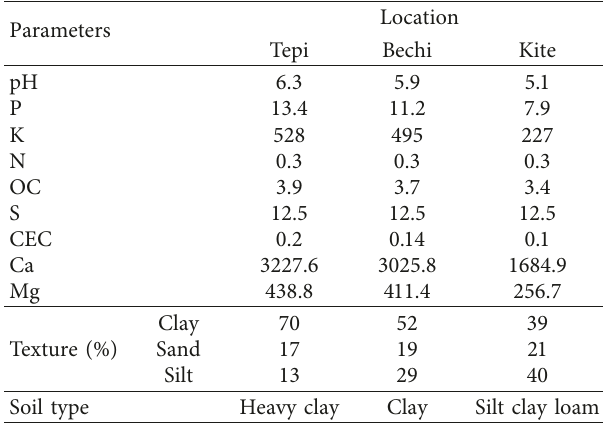
Table 3: Laboratory soil analysis results for Tepi, Bechi, and Kite testing